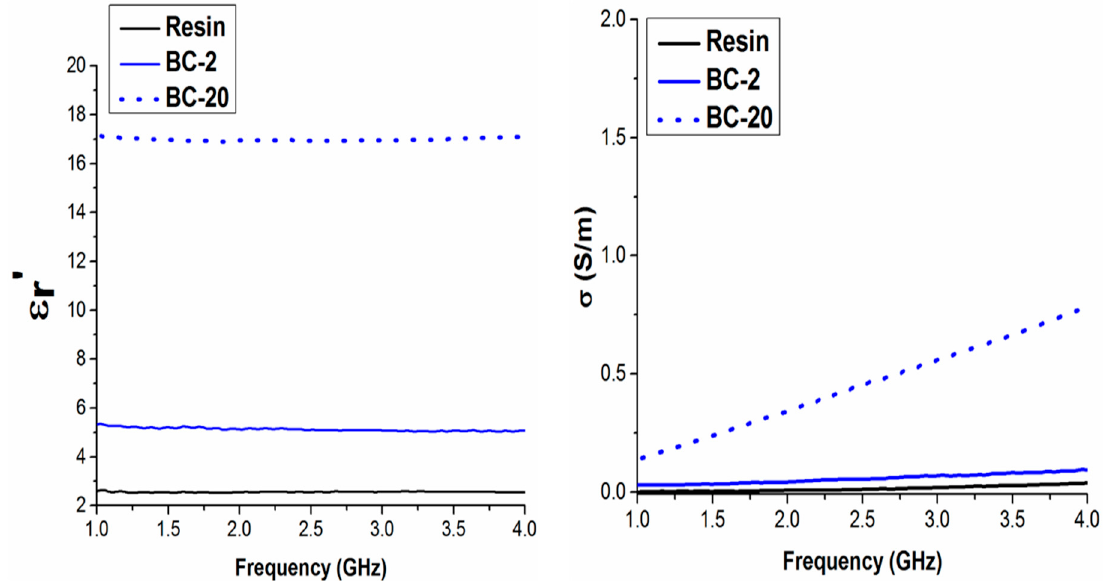
Figure 10. Real part of permittivity ( left panel ) and conductivity ( right panel ) in the microwave range for pure epoxy and epoxy composites filled with 2 and 20 wt % of biochar.